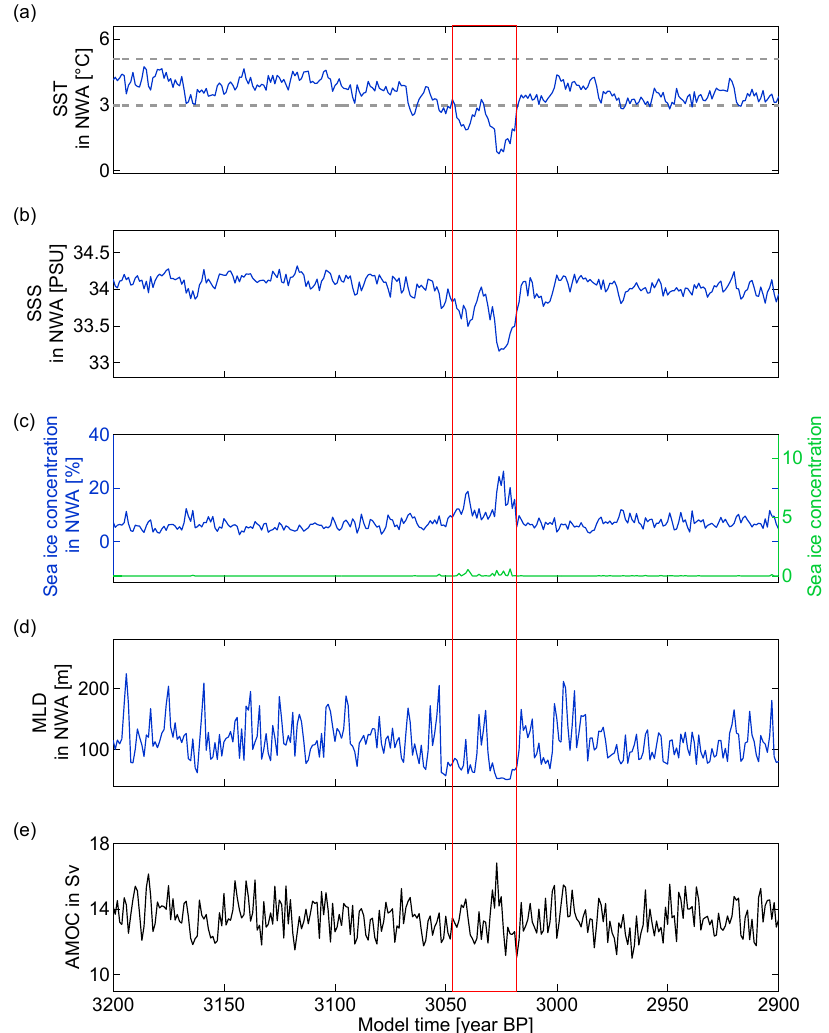
Figure 5. Zoom in on event 2. Same fields as in Fig. 2. The red box indicates the time span of the second event.